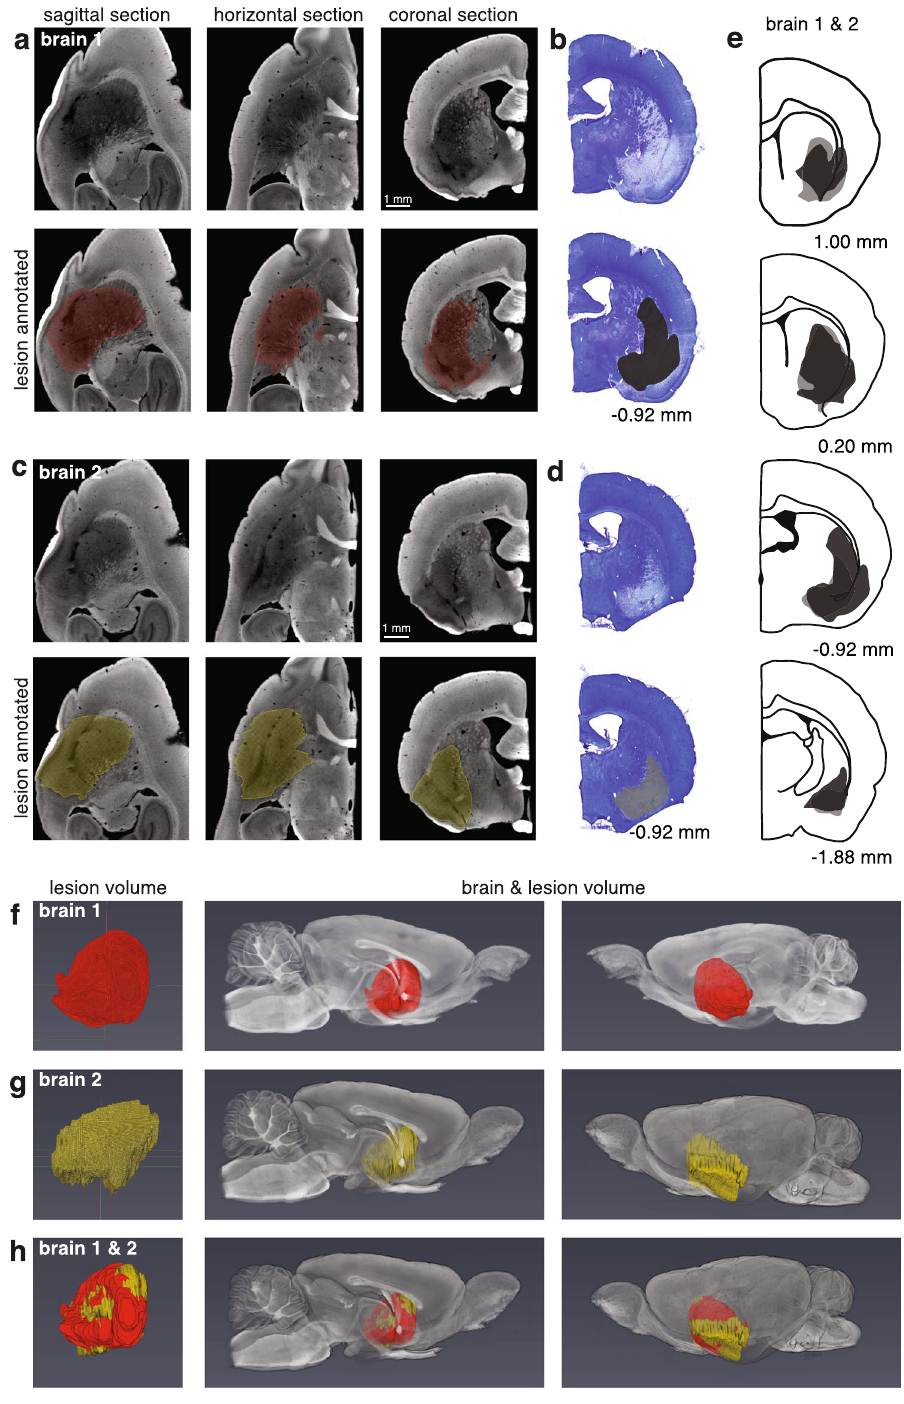
Figure 4. Comparison of dorso-lateral striatum lesion characterization using micro-CT and histology. ( a ) Sagittal, horizontal and coronal views of the left half of ‘brain 1’ processed for micro-CT imaging (13.5 μ m voxels). Top three panels show unsegmented sections; bottom three panels show the annotated lesion on the same sections. Lesion manually segmented in sagittal plane every 2 sections and subsequently interpolated. ( b ) Closest matching coronal section of the right half of ‘brain 1’ processed histologically for light microscopy. ( c , d ) Are similar to ( a , b ) except for ‘brain 2’. Brain 2 lesion manually segmented in coronal plane every 8 sections. ( e ) Lesion characterization of histology-treated right halves of brains 1 (dark grey) and 2 (light grey). The numbers in ( b , d , e ) underneath the panels correspond to positions relative to bregma. ( f ) Lesion characterization of the left half of brain 1 processed for micro-CT. First panel shows the isolated lesion. Second and third panel show the lesion in context of the brain from two viewpoints. ( g ) Same as f for brain 2. ( h ) Overlay of the lesions in ( f , g ) illustrating capability for comparison of lesion characterization with digital brain volumes. The lesion in ( f ) was registered to the lesion in ( g ) and both are shown in the context of the left half of brain